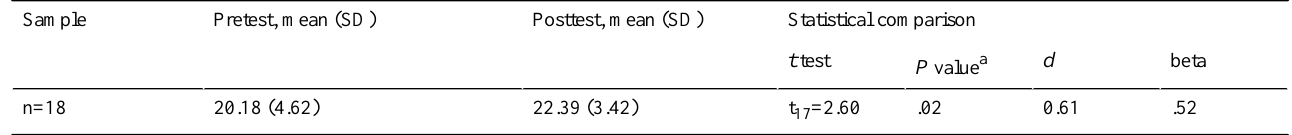
Table 3. Pretest and posttest results of the Situational Motivation Scale (SIMS; total score range, 4-28).